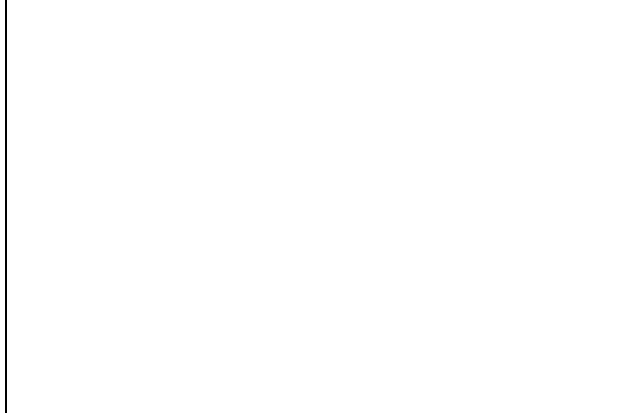
Fig. 7 : 147 KB plasmid from MDR, tetracycline resistant S